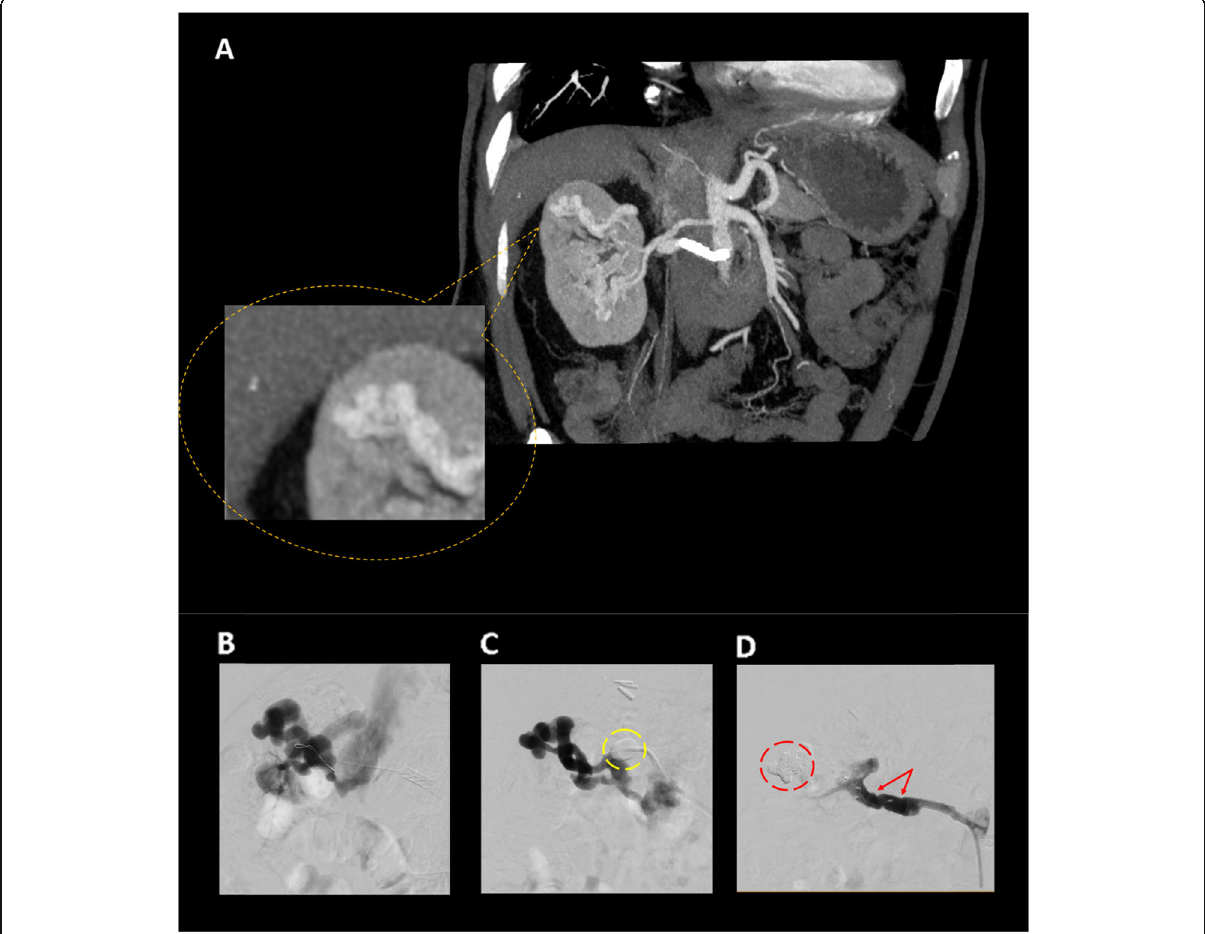
Fig. 1 Initial arteriogram ( A ) of the right kidney with double artery perfusion, of which the caudal renal artery was stented in 1997. Presence of a subcapsular arteriovenous fistula in the upper renal lobe proved progressively increasing in size, with increasing risk of rupture, prompting indication for transarterial embolization. Catheterization of the high-flow RAVF showed immediate drainage into the inferior vena cava ( B ). Usage of a Fogarty occlusion catheter ( C : yellow perforated circle) allowed for flow modulation and trans-catheter embolization via a mixture of coils and glue. Post-embolization angiogram ( D ) reveals complete occlusion of the AVF with coils ( D : red perforated circle) and vascular plugs ( D : red